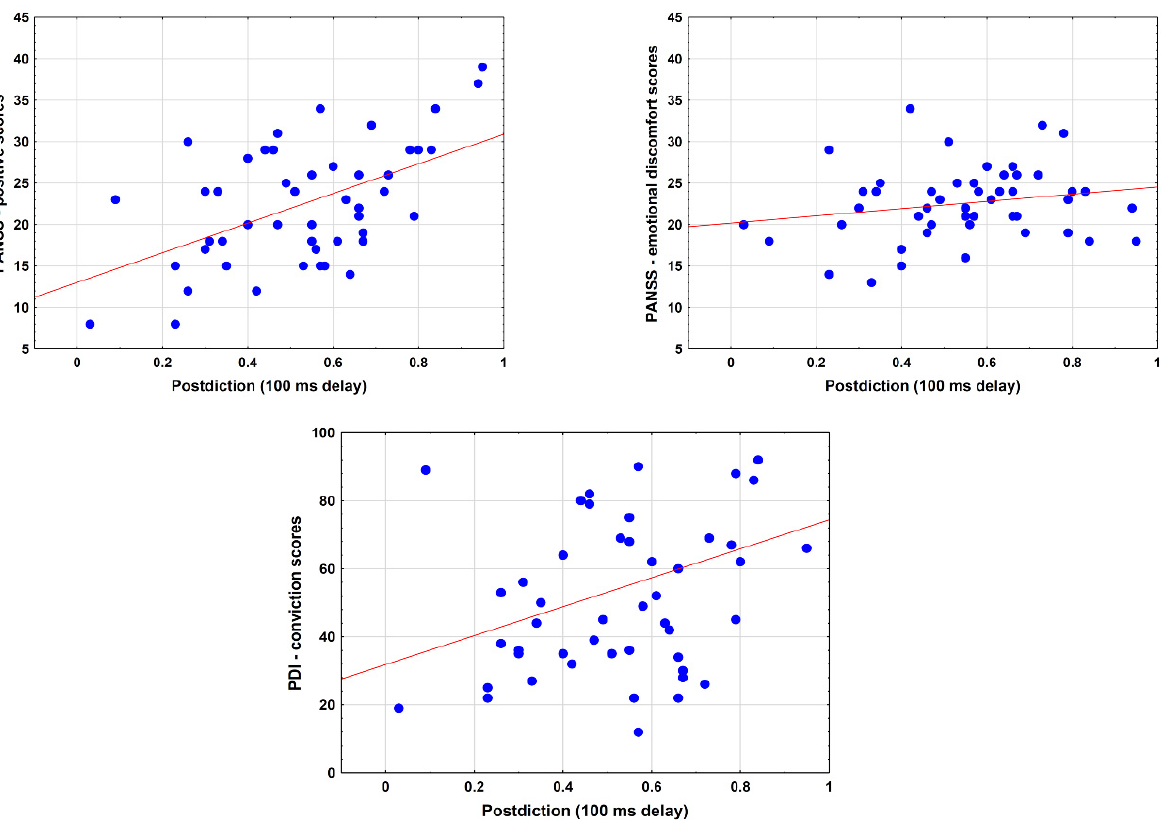
Figure 5. Correlation between postdiction at short delay (100) ms and clinical measures (PANSS—Positive and Negative Syndrome Scale, PDI—Peters et al. Delusion Inventory).